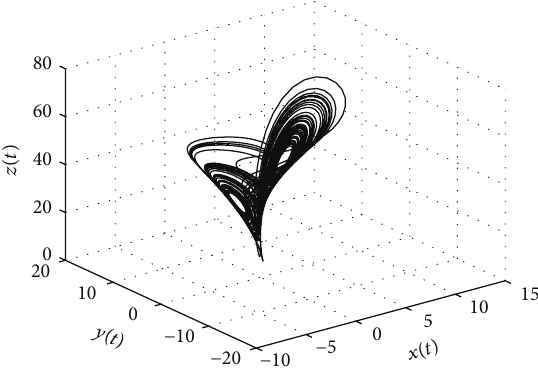
Figure 14: Asymptotic stable solution for the fractional general 𝑇 system (6) when 𝑏 1 = 10.